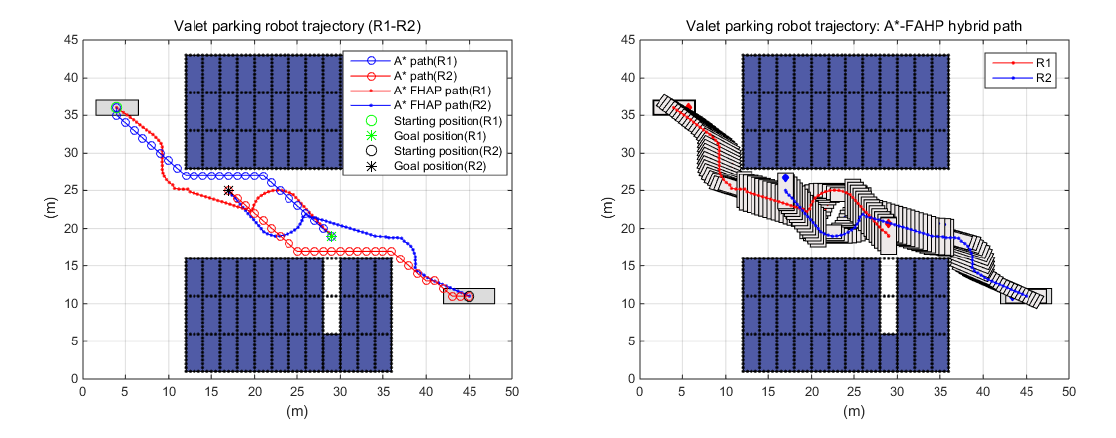
Figure 14. Path planning performance under the autonomous valet parking scenario.